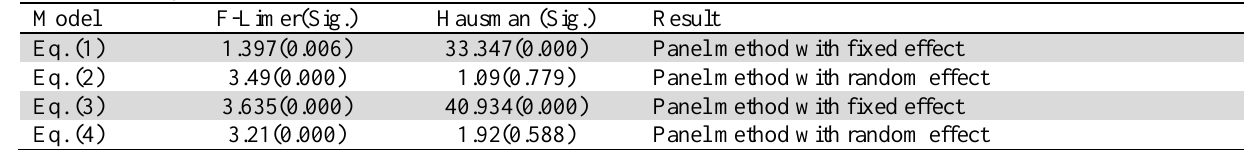
The summary of F-Limer and Hausman tests for Eq. (1) to Eq.